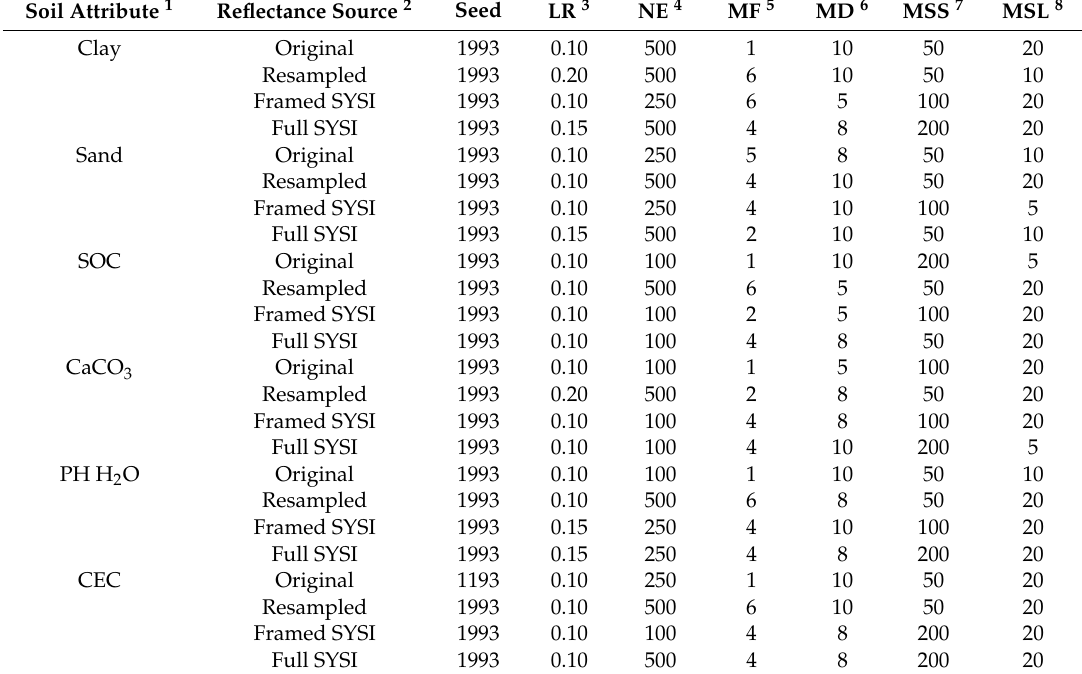
Table A2. Hyperparameters of the best regressions from gradient boosting trees, defined by 10-fold cross-validation of the training set